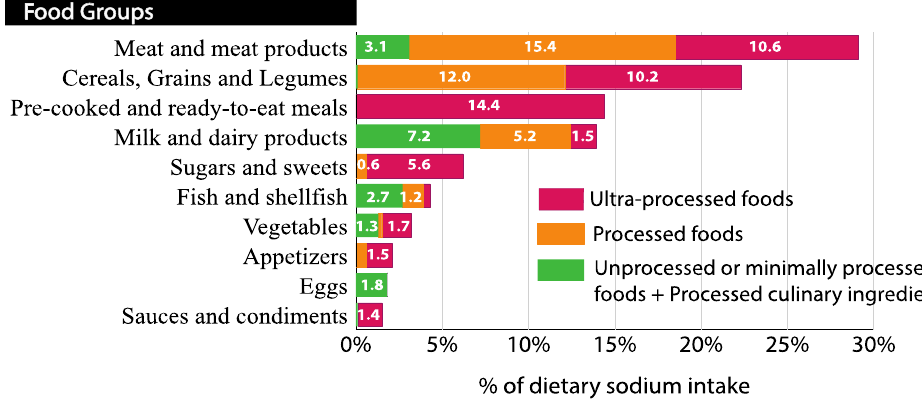
Table 4. Contribution to energy and dietary sodium intake (%) based on the food subgroups by their nutritional profile and their processing level.